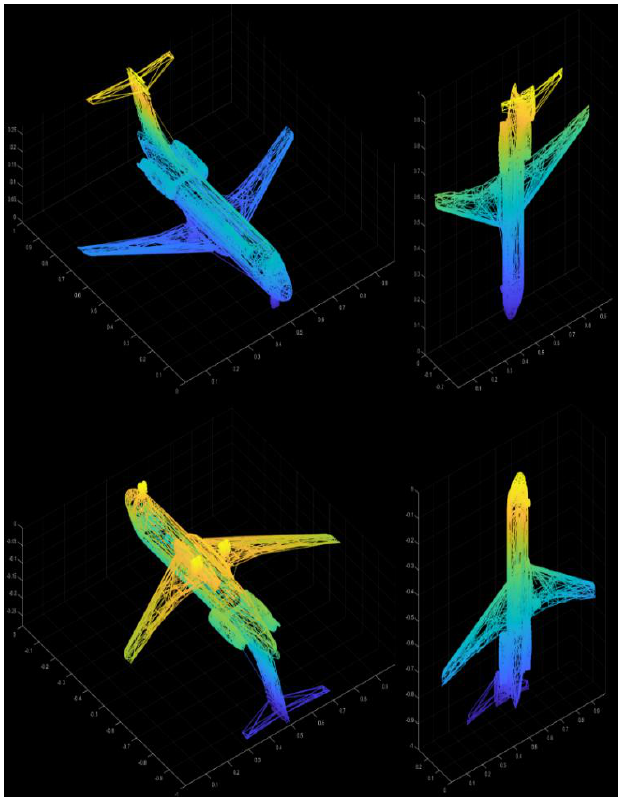
Figure 5. The original Point Clouds on the top left and three Point Clouds rotated.